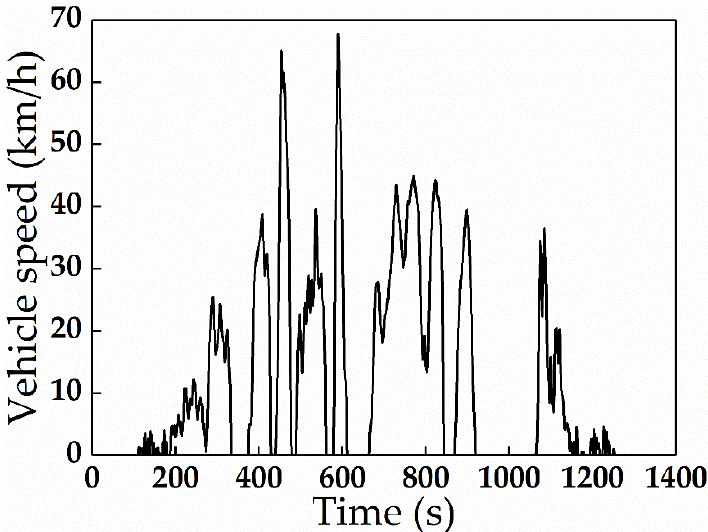
Figure 3. The vehicle speed versus time in a complete driving event.